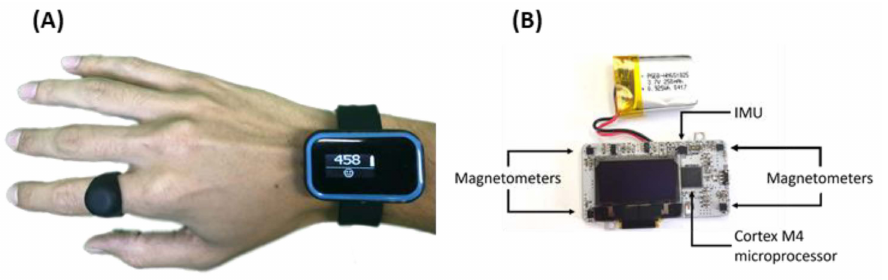
Figure 1. The Manumeter. ( A ) The Manumeter is comprised of a sensing wrist band a ring containing a permanent magnet. ( B ) The Manumeter sensing board, with four magnetometers positioned at the corners of the board, an IMU with six degrees of freedom, an OLED display, and a non-ferromagnetic battery. A Cortex M4 microcontroller controls the